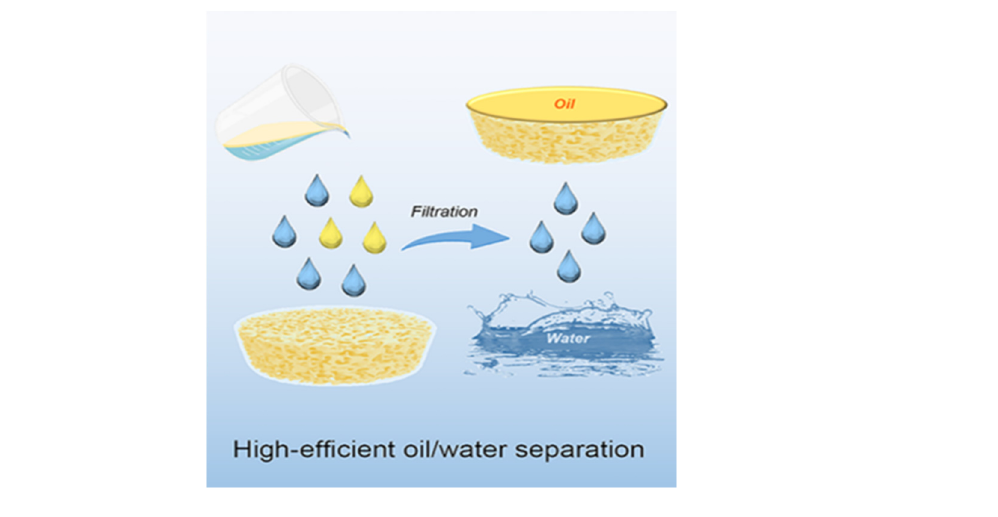
Figure 11. Schematic diagram of oil-water separation of PAC-g-PEI gas coagulant [161]. Reprinted (adapted) with permission from (Fan, B.; Qi, B.; Wang, P.; Liu, Y.; Yu, Y.; Wang, Q.; Ren, X. Mechanically Tough and Regenerable Antibacterial Nanofibrillated Cellulose-Based Aerogels for Oil/Water Separation. Langmuir 2022 , 38 , 10716–10727.) Copyright American Chemical Society.